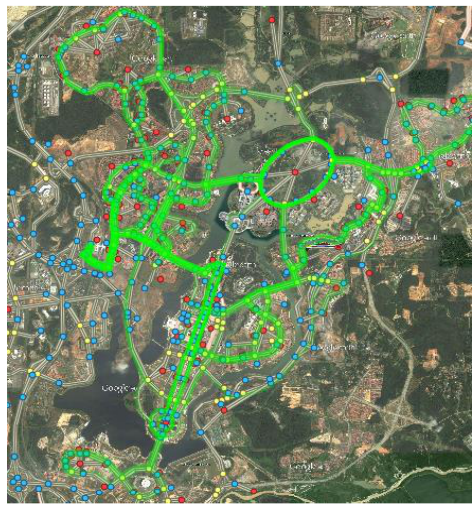
Fig. 2. The study area of Putrajaya,